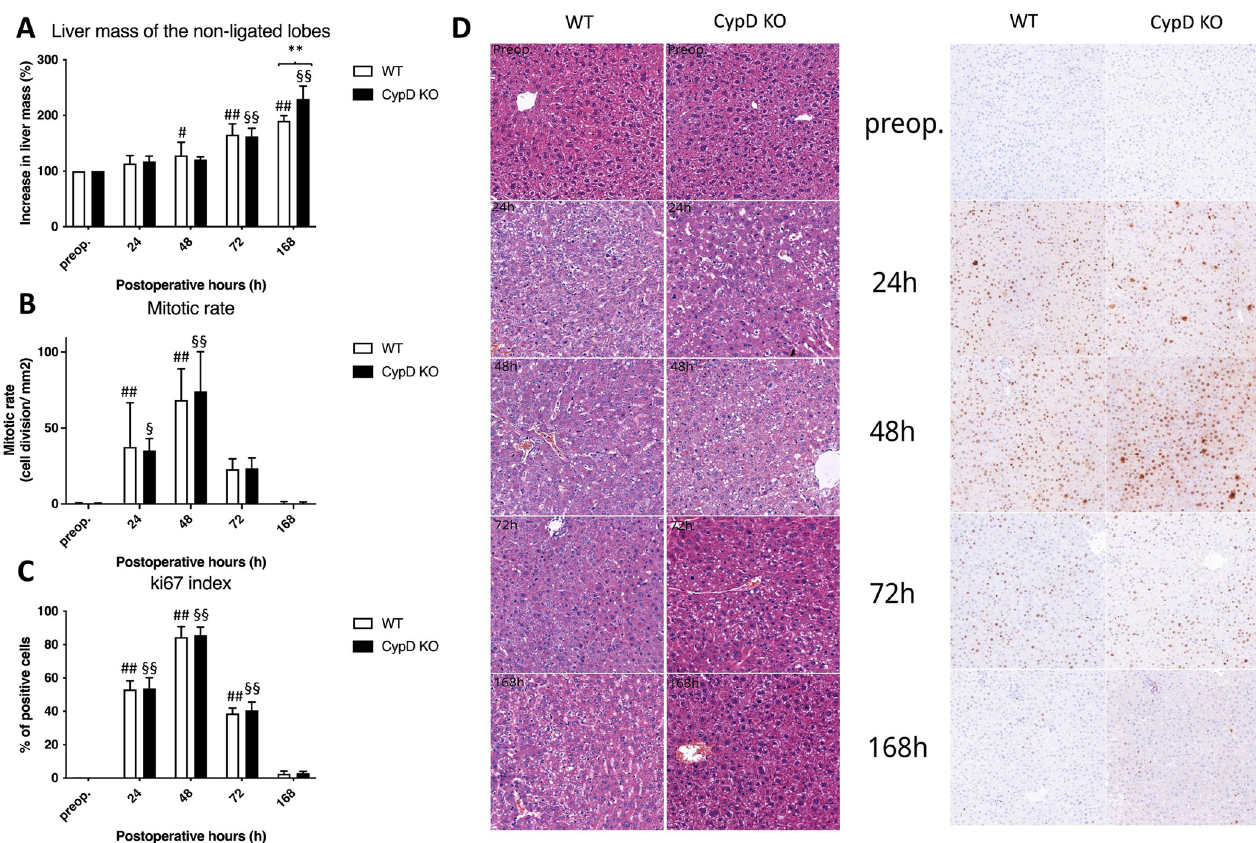
Fig 7. Liver regeneration following Associating Liver Partition and Portal vein ligation for Staged hepatectomy (ALPPS)in the ligated right medial lobe. Increase in liver mass of non-ligated lobe (A) and mitotic rate (B) and ki67 index (C) preoperatively (preop., 0 h), and at 24 h, 48 h, 72 h, and 168 h after ALPPS (N = 6 per time point per group). Histological structure on the left (hematoxylin and eosin stain; original magnification: × 150)and ki67 immunohistochemistry (on the right) of the regenerating right median (RM) lobe (D) preoperatively (preop.) and at 24 h, 48 h, 72 h, and 168 h after ALPPS in the Cyclopihilin D knockout (CypD KO) and wild type (WT) group. � P < 0.050, �� P < 0.0010 versus wild type (WT); # P < 0.050, ## P < 0.001 WT versus corresponding controls (preop.); § P < 0.050, §§ P < 0.0010 CypD KO versus corresponding controls (preop.). Statistical analysis was performed with a two-way ANOVA and Tukey’s post hoc